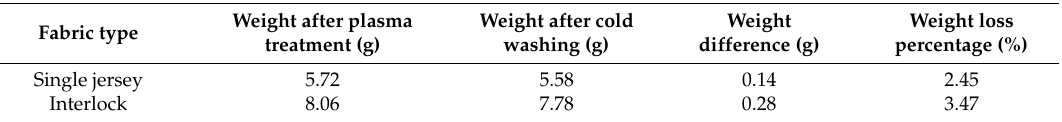
Table 3. Weight loss of plasma-treated knitted fabric with cold (30 ◦ C) washing (plasma condition: 150 W output power and 0.4 L/min flow rate).